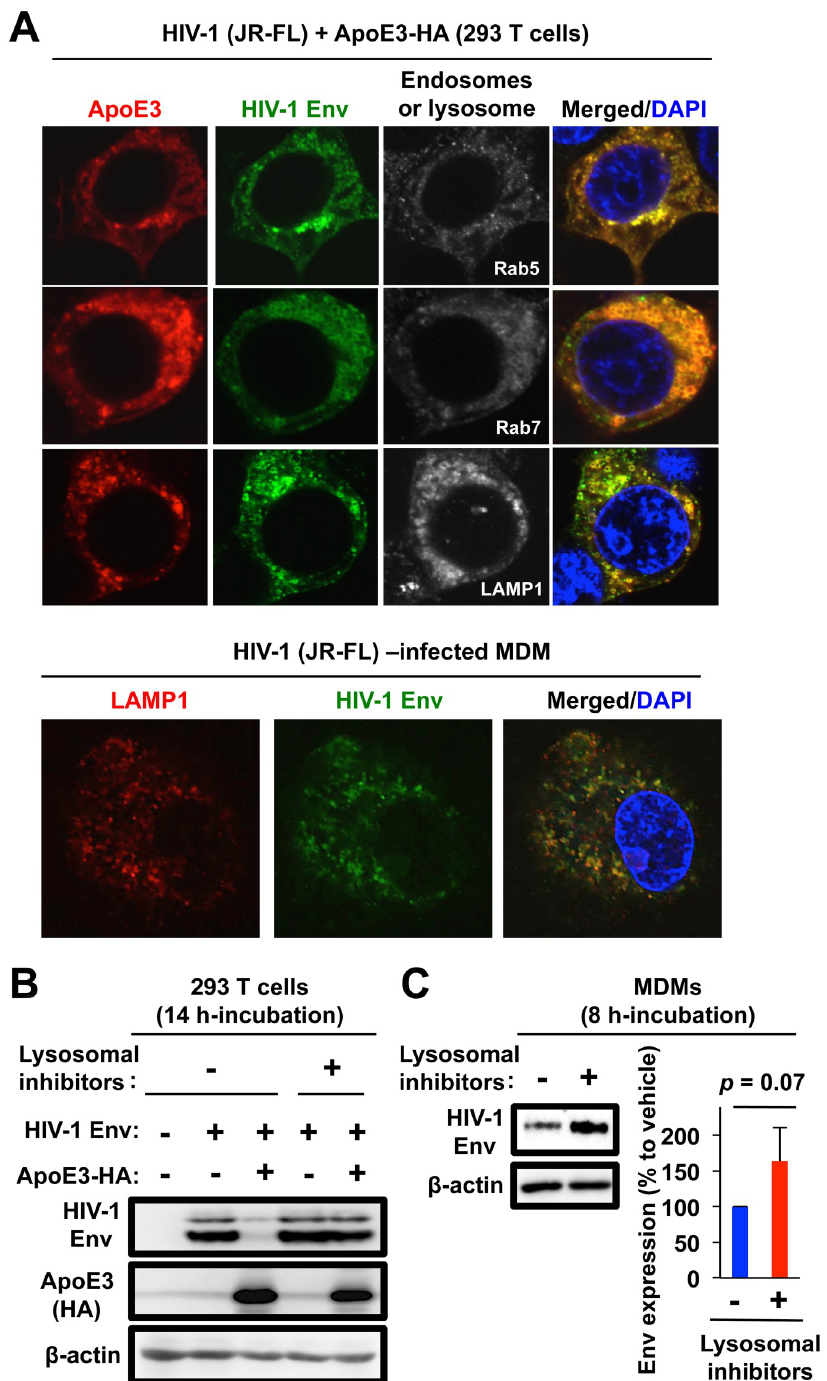
Fig 8. Presence of Env in endosomes and lysosomes in ApoE-expressing 293T cells and HIV-1-infected MDM, and effect of lysosomal inhibitors on ApoE-induced suppression of Env expression. (A) The 293T cells (upper panels) were co-transfected with 100 ng of the HIV-1 molecular clone JR-FL and 100 ng of pCAG-ApoE3-HA in a 2-well chamber slide. Twenty-four hours post-transfection, the cells were co-stained with anti-HIV-1 Env, anti-HA, and either anti-Rab5 (early endosome), anti-Rab7 (late endosome), or anti-LAMP1 (lysosome) antibodies, and then the signals were visualized with AlexaFluor488 goat anti-Human IgG, AlexaFluor594 donkey anti-mouse IgG and/or AlexaFluor647 donkey anti-rabbit IgG antibodies. MDMs (lower panels) infected with HIV-1 JR-FL (100 ng/mL p24)